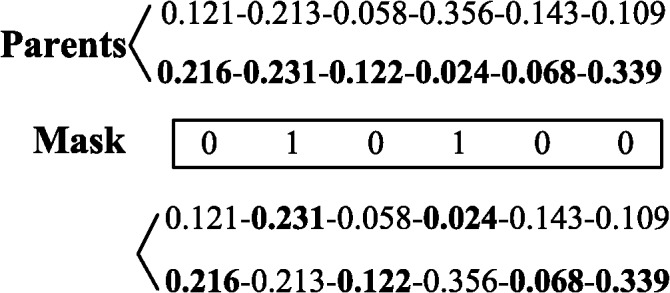
Example of uniform crossover.